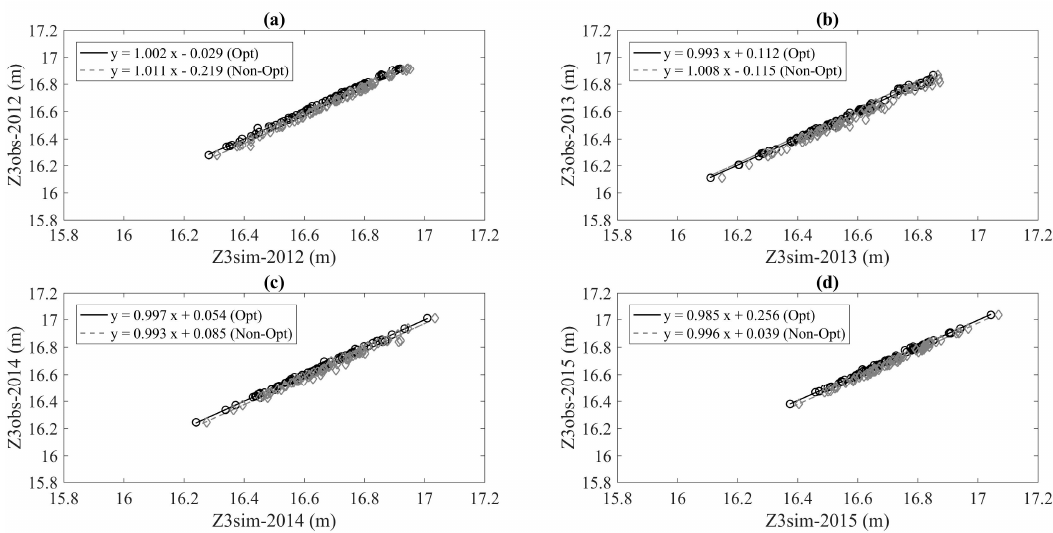
Figure 11. For every year: 2012 ( a ); 2013 ( b ); 2014 ( c ) and 2015 ( d ), the linear interpolation of Z3 obs and Z3 sim for both optimized and non-optimized models.